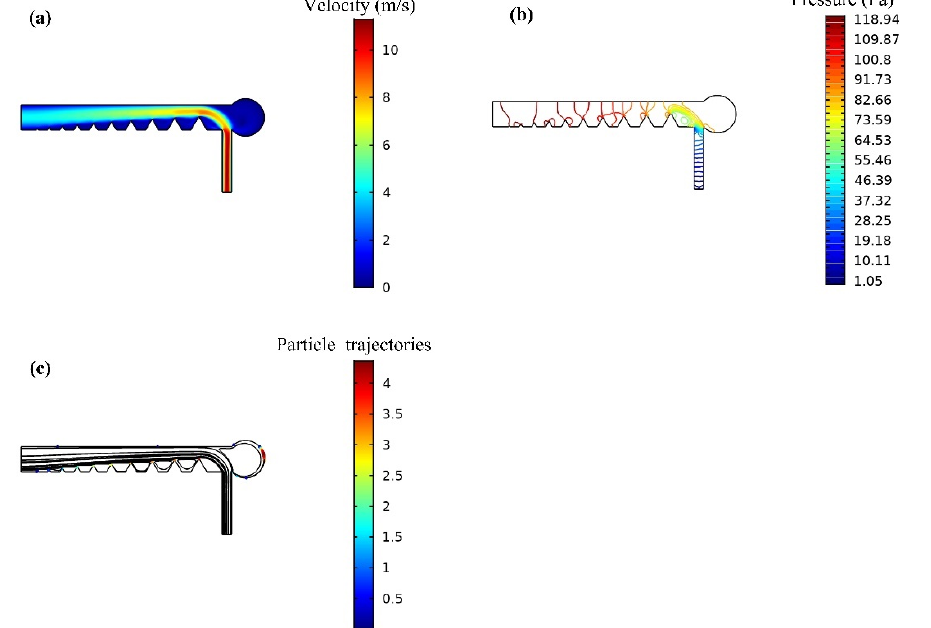
Figure 6. Simulation results of the microfluidic chip. ( a ) Velocity distribution, ( b ) Pressure distribu- tion, ( c ) 16 µ m particle trajectory.